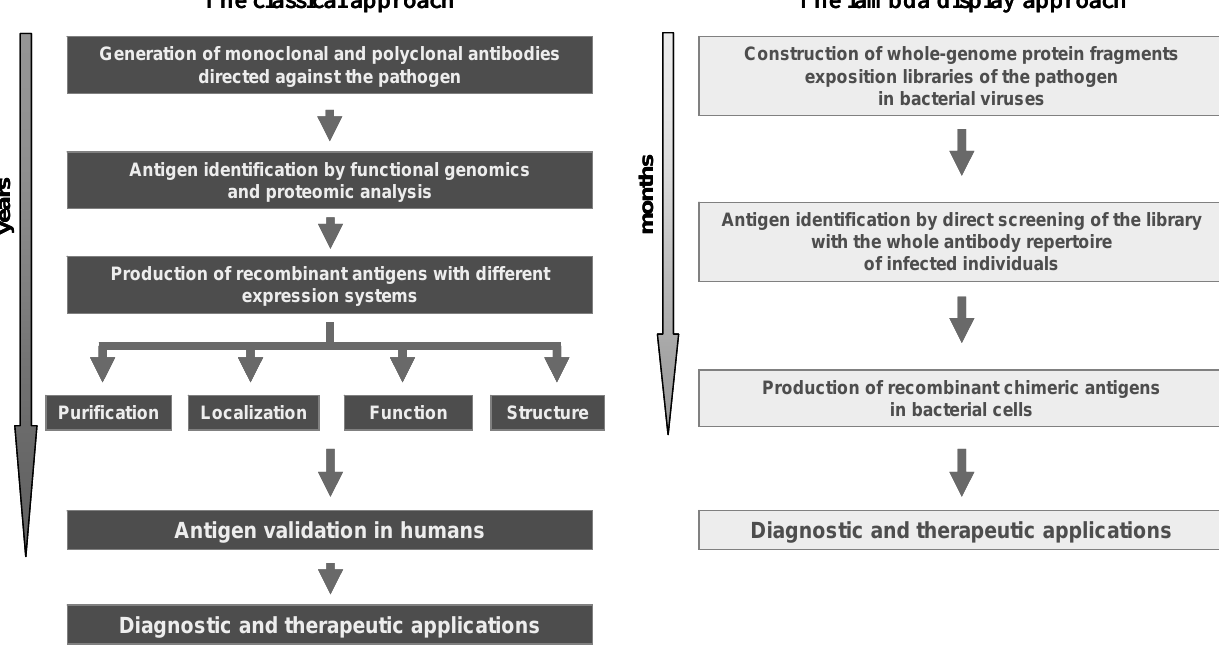
Figure 4. Comparison of the lambda display approach with respect to classical methods in antigen discovery